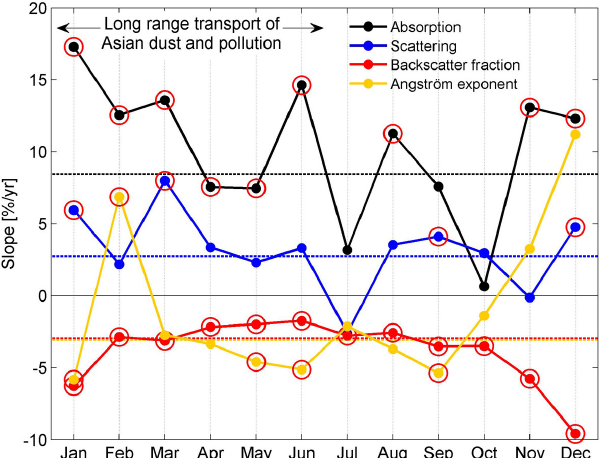
Fig. 8. Seasonal Mann-Kendall trend analysis for the MLO scat- tering and absorption coefficient as well as the backscatter fraction and the scattering ˚Angstr¨om exponent. The symbols have the same meaning as in Fig.